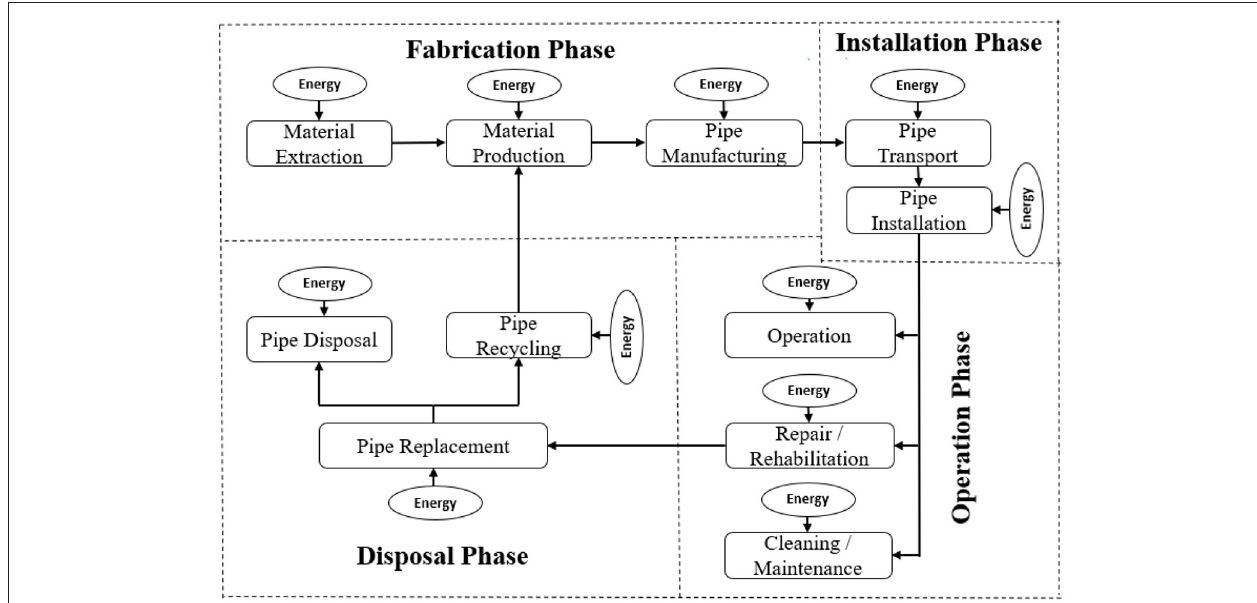
FIGURE 1 | Life-cycle energy analysis and life stages.